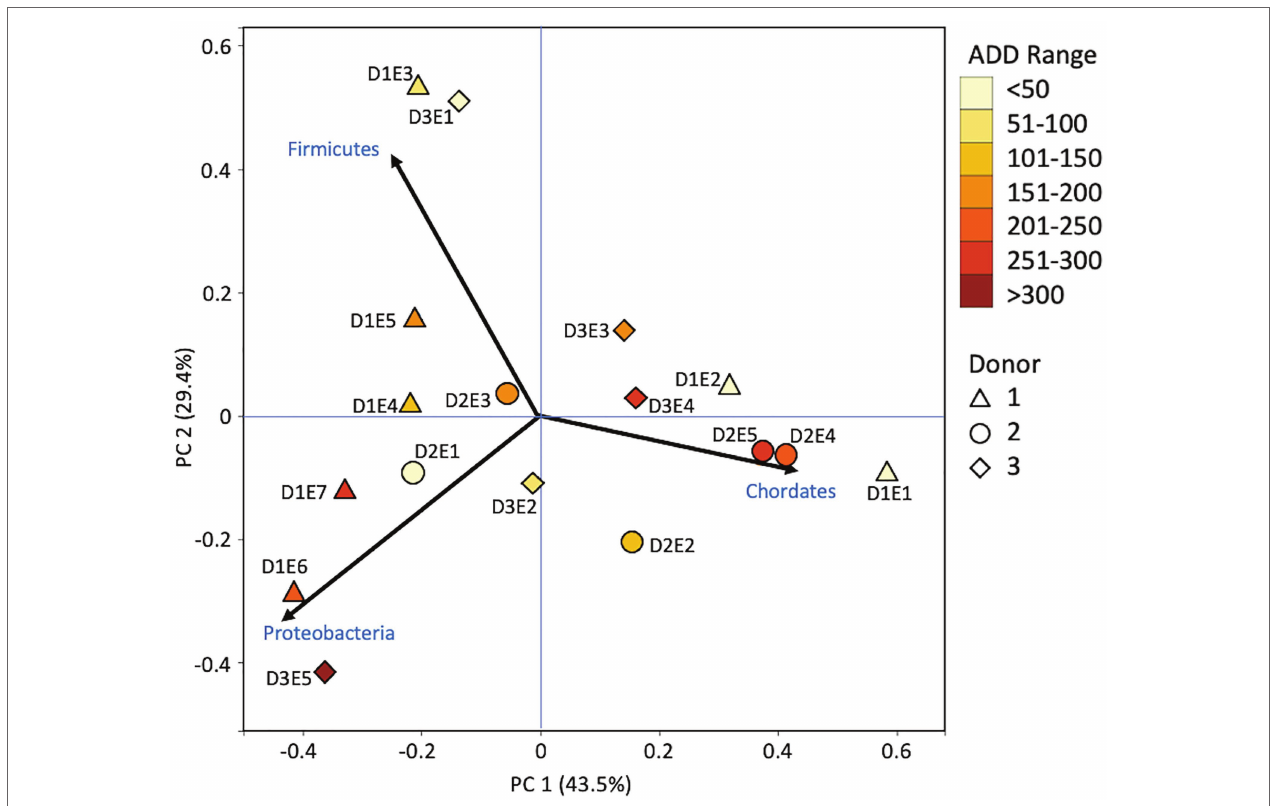
FIGURE 7 | Principal components analysis plot for the proportional data of bacterial and eukaryotic phyla observed from shotgun MetaG sequencing from oral samples of three human donors (Donors 1, 2, and 3) during decomposition. Shading is added to the symbols [triangles for Donor 1 (D1), circles for Donor 2 (D2), and diamonds for Donor 3 (D3)] to show earlier (lighter shading) to later (darker shading) ADD and also times sampled (from E1 to E7 for D1 and E1 to E5 for D2 and D3, indicating first sample to last sample